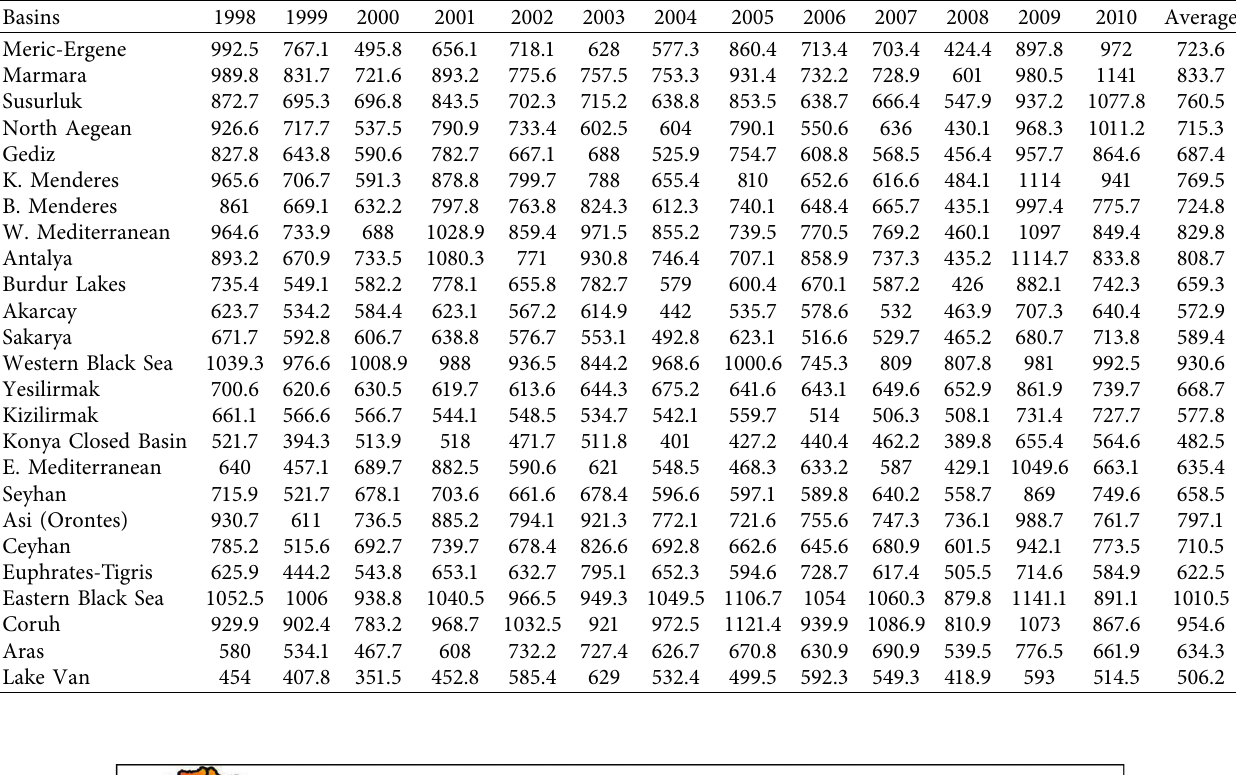
Table 4: Total annual precipitation (mm) from TRMM data for the years 1998–2010.